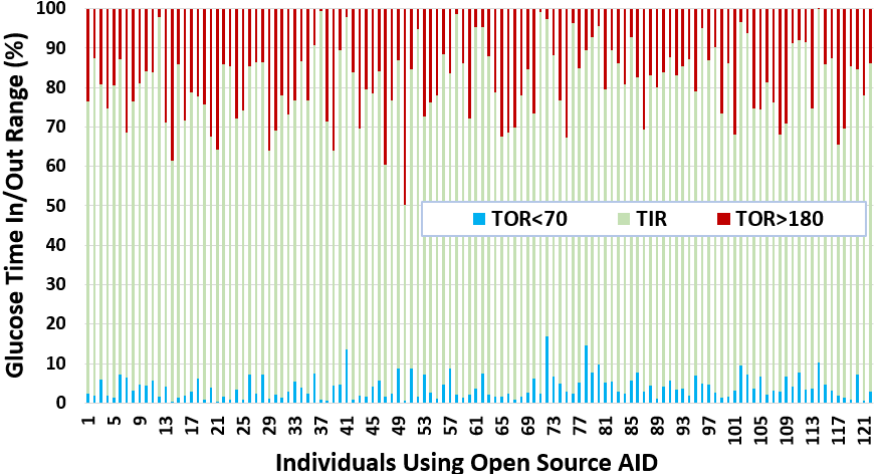
Figure 3. Glucose TIR and TOR for insulin-requiring individuals using open-source AID systems. Total number of individuals ( n ) = 122. The average TIR for insulin-requiring individuals in OpenAPS Data Commons dataset is 77%. There is a higher tendency for individuals to have more TOR situations over the higher TIR limit (180 mg/dL) as compared to TOR situations less than the lower TIR limit (70 mg/dL).